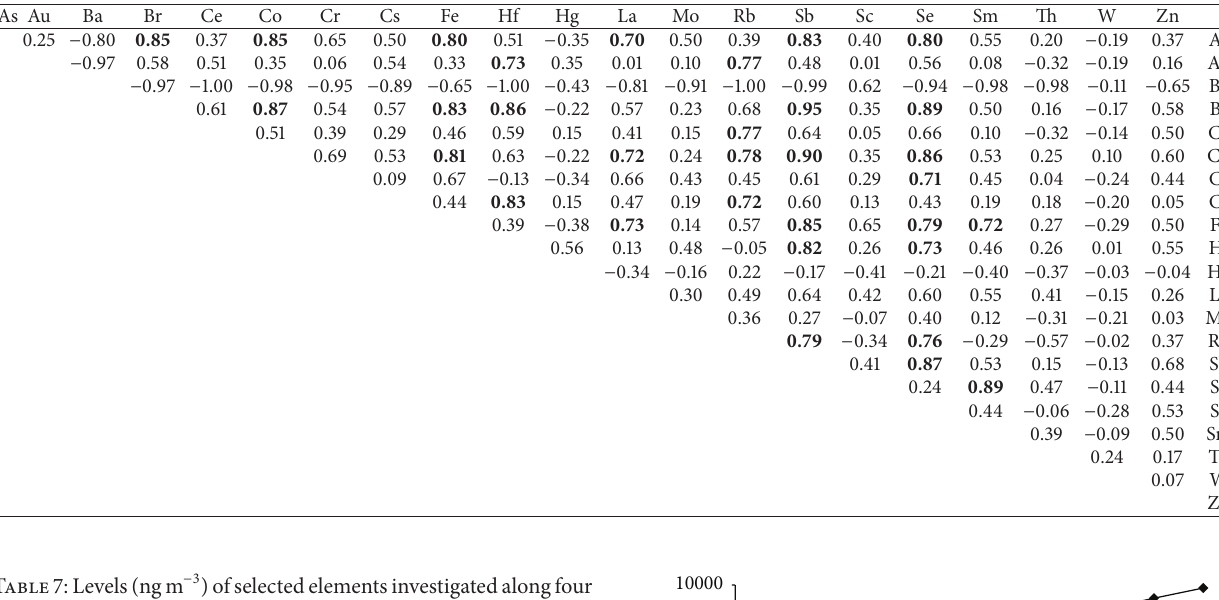
Table 6: Correlation coefficients for the trend of concentrations of analyzed elements present in PM As Au